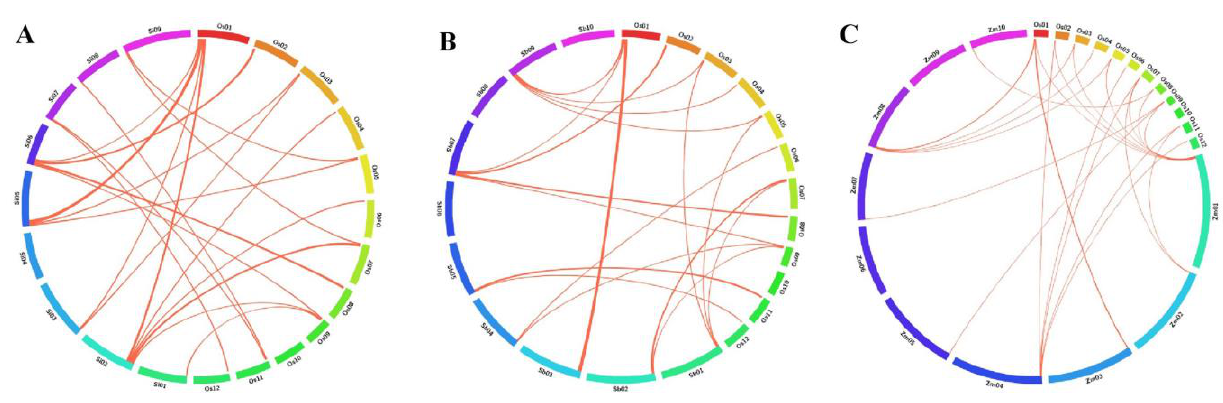
Figure 9. Comparative orthologous relationship of WRKY genes among (A) rice and foxtail millet, (B) rice and sorghum, (C) rice and maize. All segments denote chromosome and red links represent the genomic regions with a corresponding target chromosome.